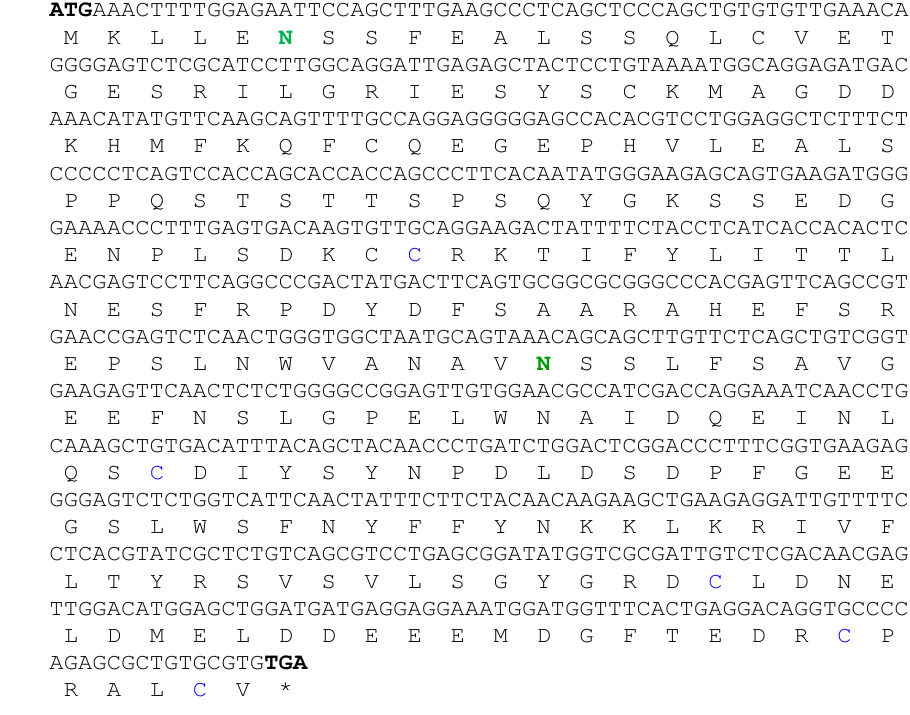
Figure 1. Coding sequence and deduced amino acid sequence of the P. olivaceus Maf1 ( PoMaf1 ). Start and stop codons in the coding region are in bold. Nucleotide and deduced amino acid residues are numbered to the left. Potential N-glycosylation sites are denoted in bold green. The predicted disulfide bond is indicated in blue.